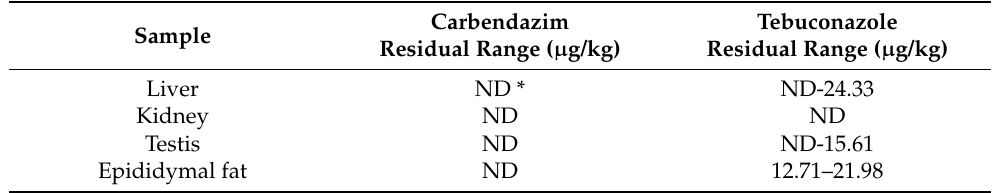
Table 4. Concentration of carbendazim and tebuconazole in mouse tissues after 4 weeks of adminis- tration of the ADI dose.